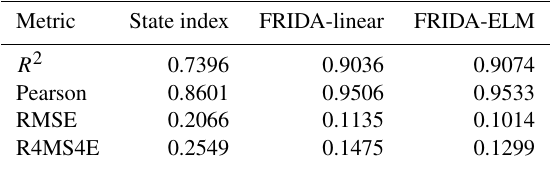
Table 3. Accuracy of the state index, FRIDA-linear, and FRIDA- ELM in reproducing the supply deficit, quantified in terms of co- efficient of determination R 2 , the Pearson correlation coefficient, the root mean square error (RMSE), and the fourth grade root mean square error (R4MS4E).